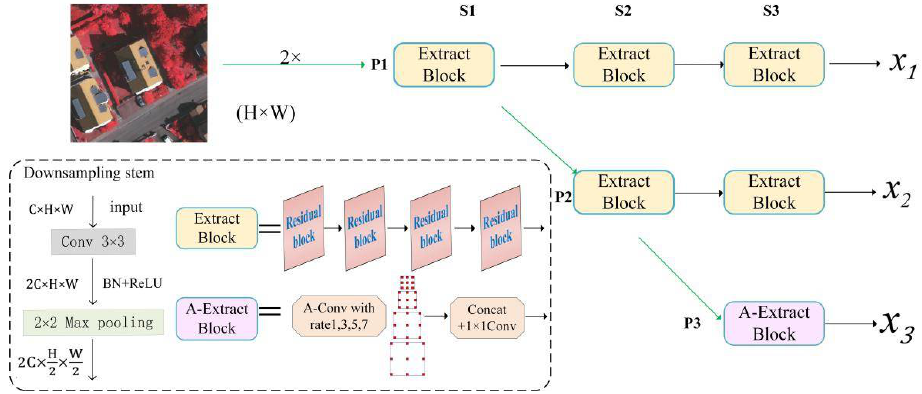
Figure 3. Illustration of our multi path parallel network (MPP-Net), the green arrow is the operation of downsampling stem and the dilation rates of 3 × 3 atrous convolutions are 1, 3, 5, and